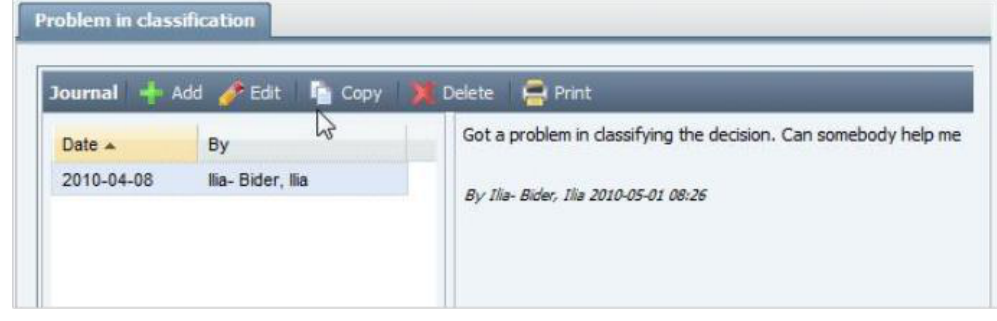
Figure 10. Example of a journal